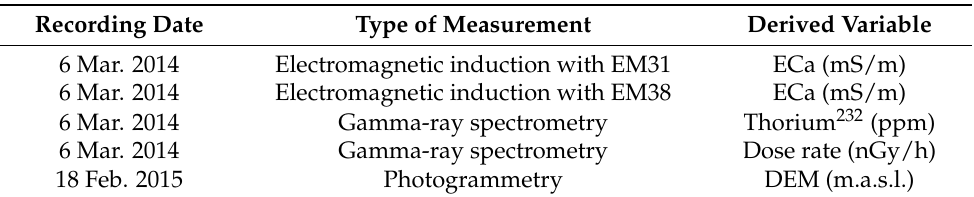
Table 2. Overview of the variables in the evaluation dataset, which were not derived from the hyperspectral